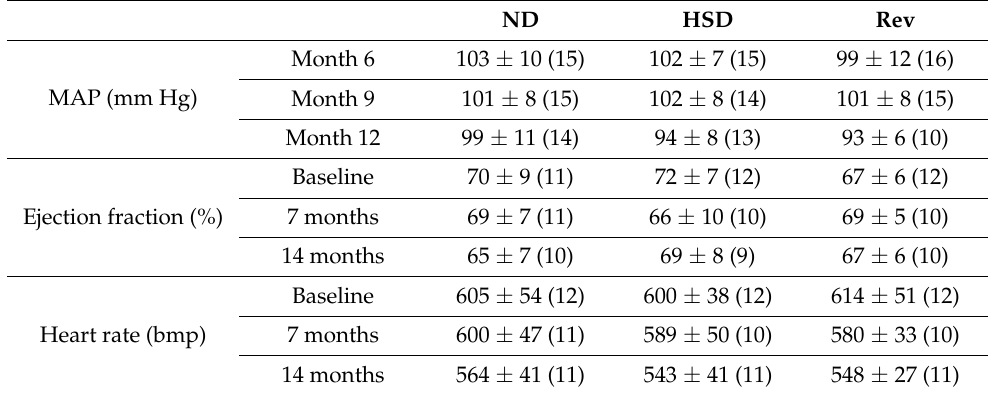
Table 2. Mean arterial pressure and heart rate in beats/minute (bpm) measured by tail-cuff plethys- mography (n = 10–16) and left ventricle ejection fraction, as estimated by cardiac MRI (n = 9–12). Data shown as means ± SDs. Number of mice in